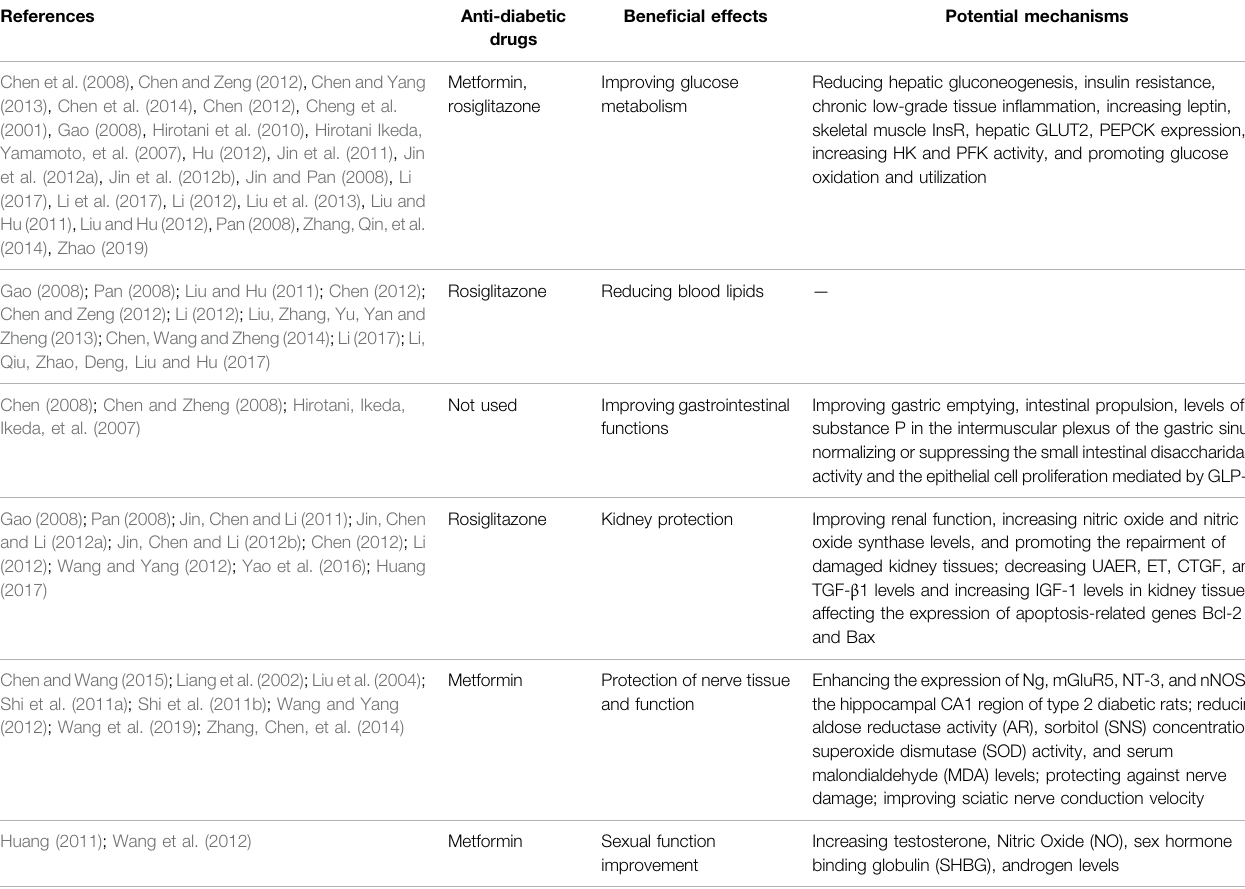
TABLE 3 | Herb-drug interactions with the anti-diabetic drugs and the potential mechanisms of JGSQW as a treatment for T2DM reported by preclinical